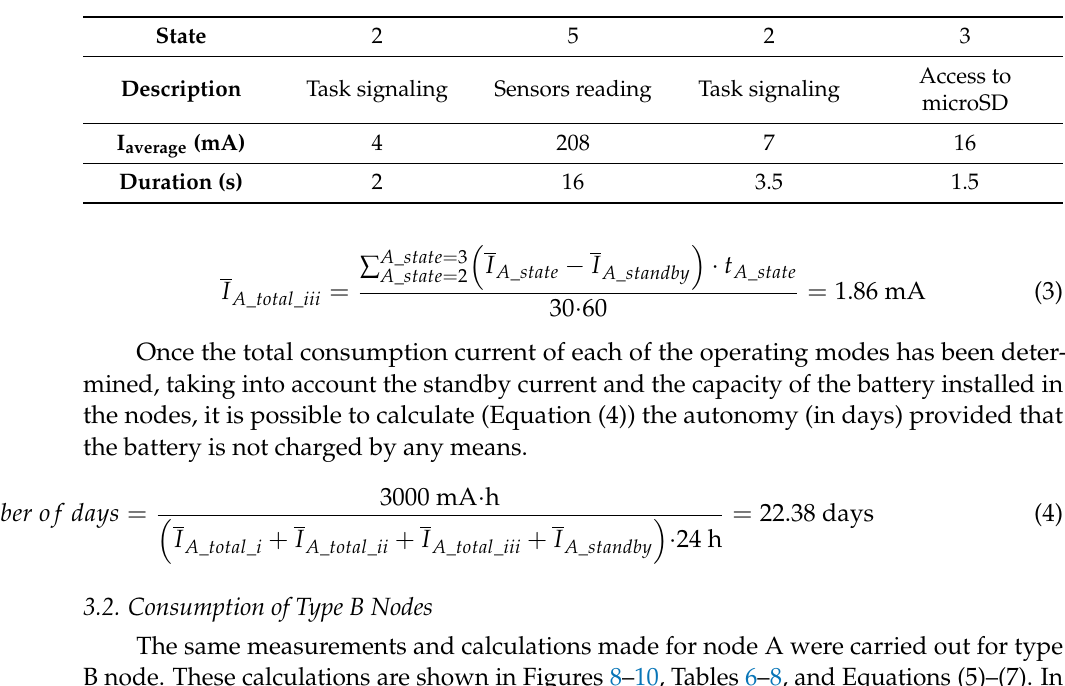
Table 5. Description of functional states of node A—mode (iii).